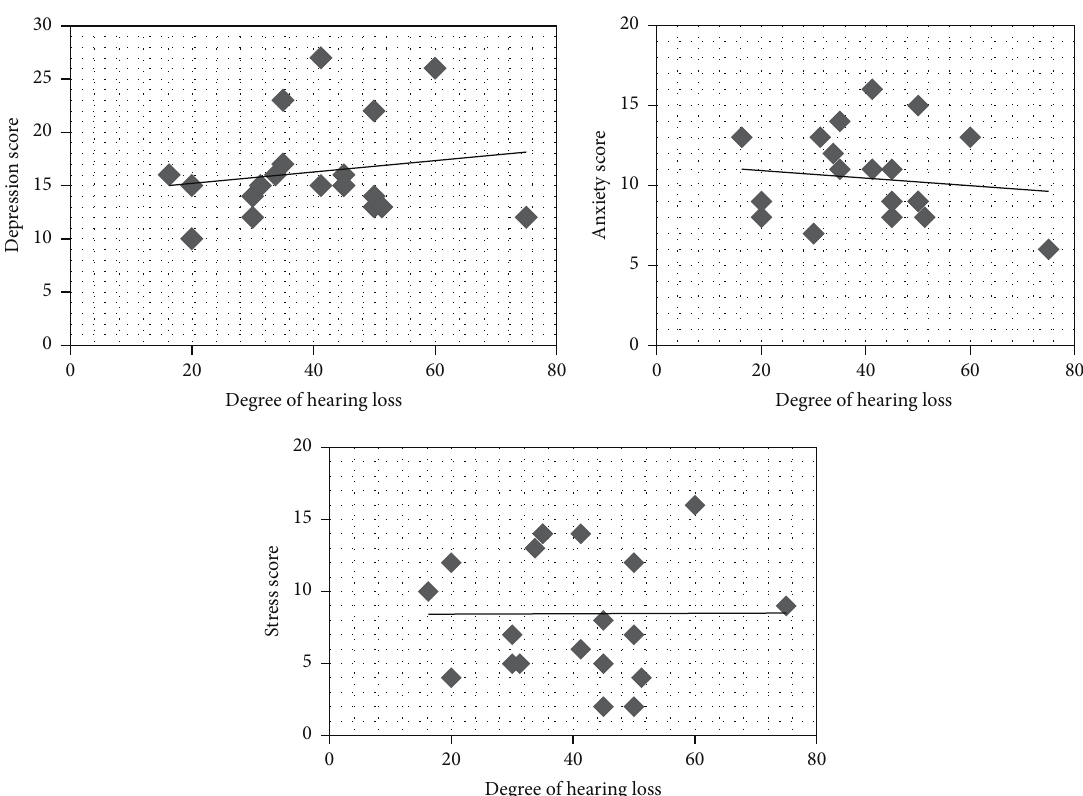
Figure 4: Scatter plots of correlation between the degree of hearing loss and the different scales of